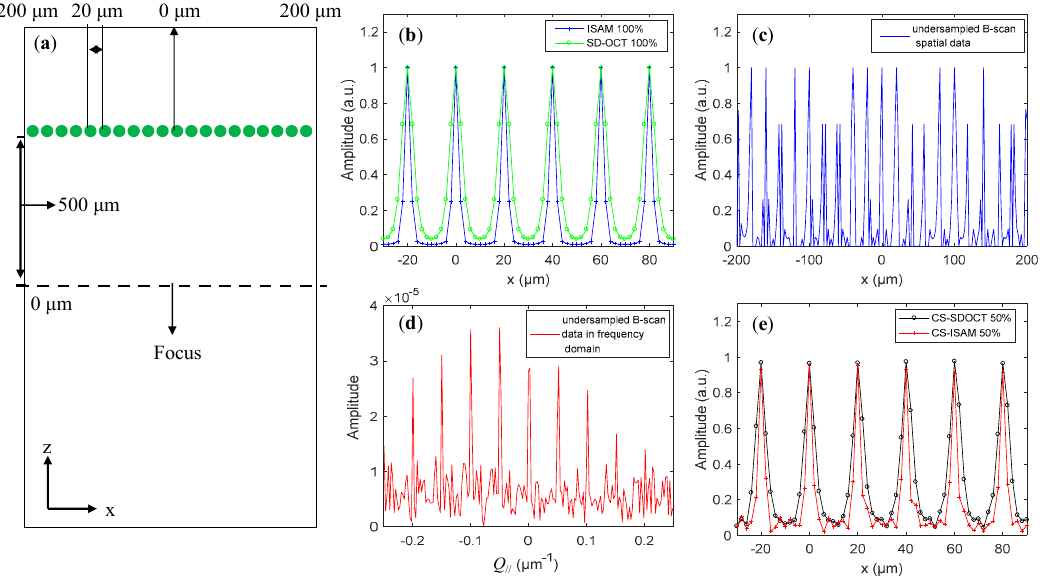
Figure 4. ( a ) Schematic diagram of the simulated sample, ( b ) the reconstructed structural signals of the SD-OCT and ISAM obtained by 100% B-scan data, ( c ) under-sampled B-scan data in spatial domain with a sampling rate of 50%, ( d ) under-sampled B-scan data in the lateral spatial frequency Q // domain, and ( e ) reconstructed structural signals of ISAM and SD-OCT using 50% data.